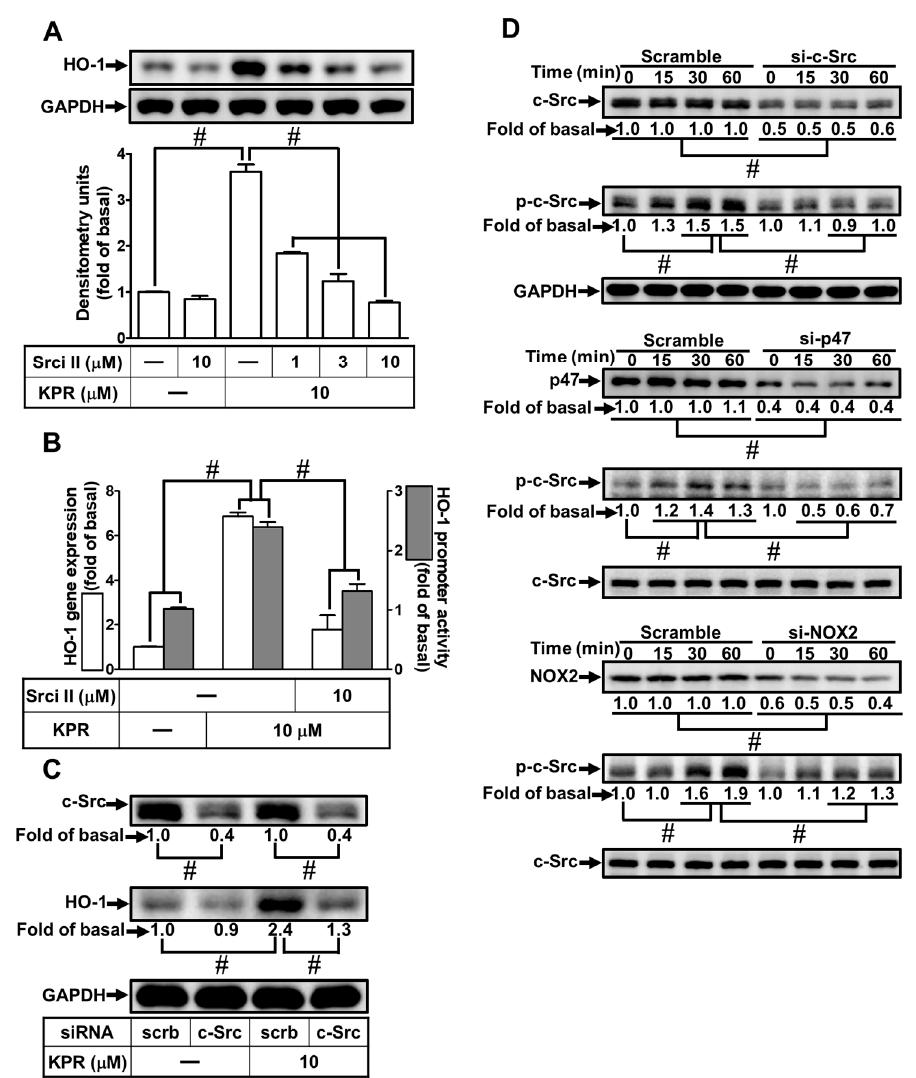
Figure 5. c-Src participates in KPR-induced HO-1 expression. ( A ) HPAEpiCs were pretreated with various concentrations of Srci II for 1 h and then incubated with DMSO or KPR (10 µ M) for 16 h. The protein expression of HO-1 was determined by Western blot using GAPDH as a loading control. ( B ) Cells were pretreated with or without Srci II (10 µ M) for 1 h and then incubated with DMSO or KPR (10 µ M) for the indicated time intervals. The HO-1 mRNA expression and promoter activity were analyzed by real-time PCR (6 h) and promoter activity assay (8 h), respectively. ( C ) Cells were